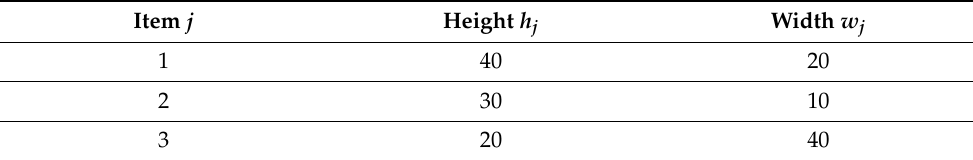
Table 1. Data for Example 1.